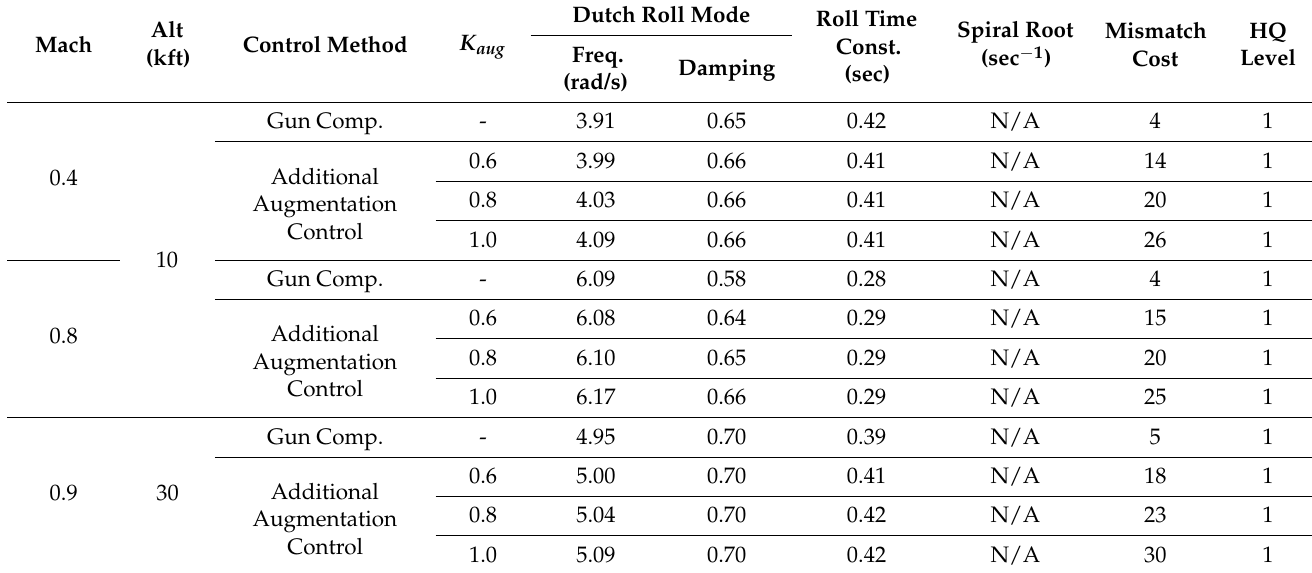
Table 2. Result of equivalent system analysis for each control method and K aug